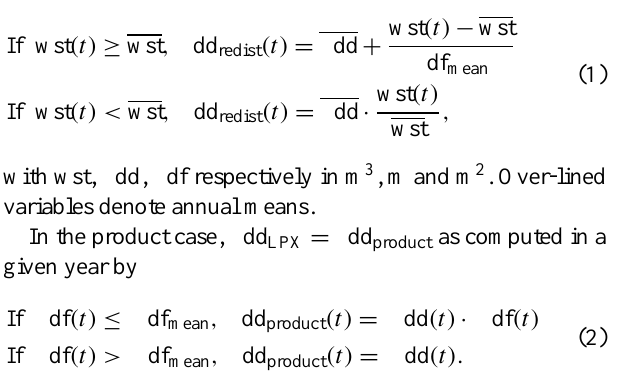
proportional to the product of flood depth and flood